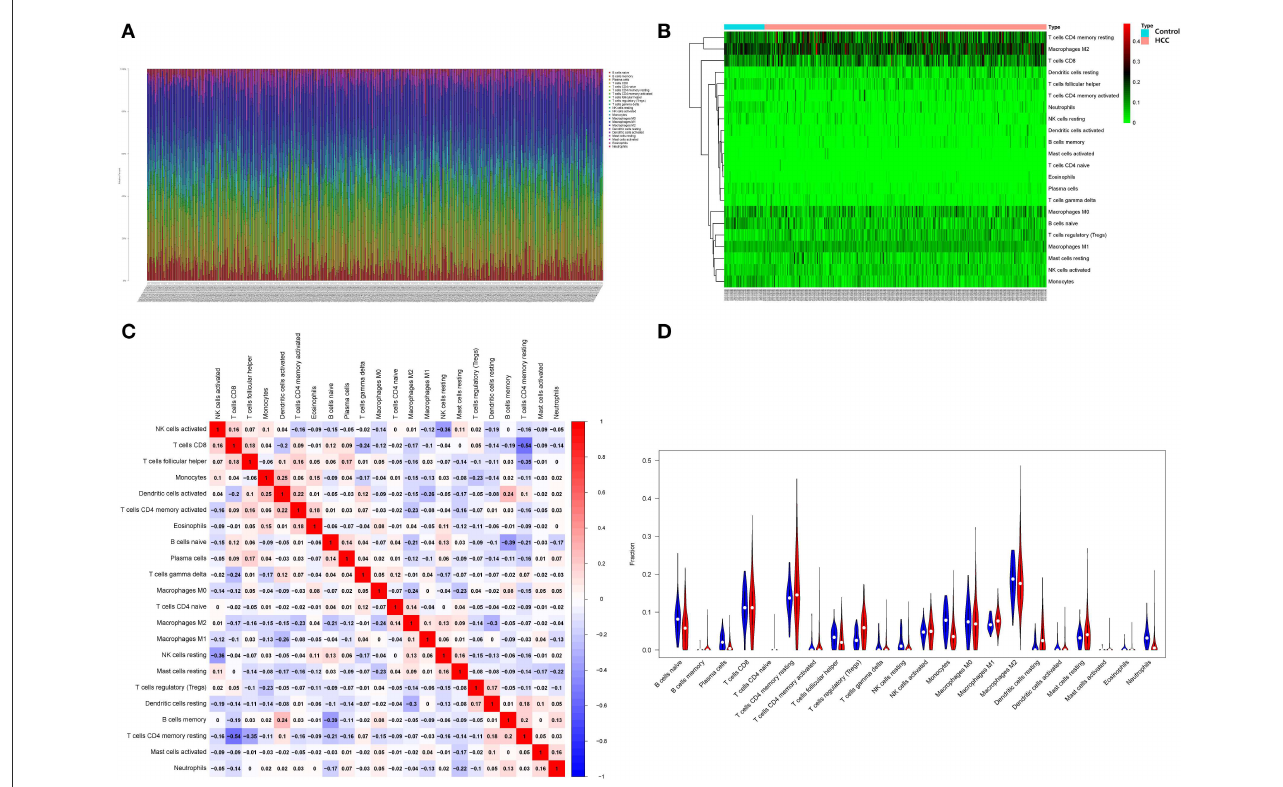
FIGURE8 Infiltration analysis of immune cells. (A) Distribution of immune cells in HCC; (B) HCC immune cell distribution heat map; (C) HCC immune cell interaction heat map; (D) Image showing the relative amount of immune cells in HCC.